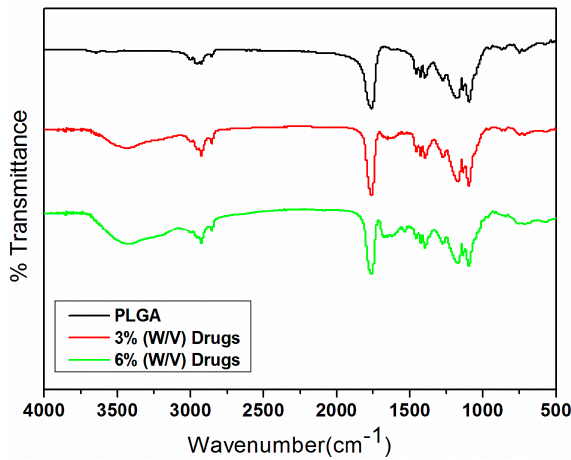
Figure 6. FTIR spectra of electrosprayed nano/microparticles. Abbreviations: FTIR, Fourier transform infrared; PLGA, poly( D , L )–lactide– co –glycolide.